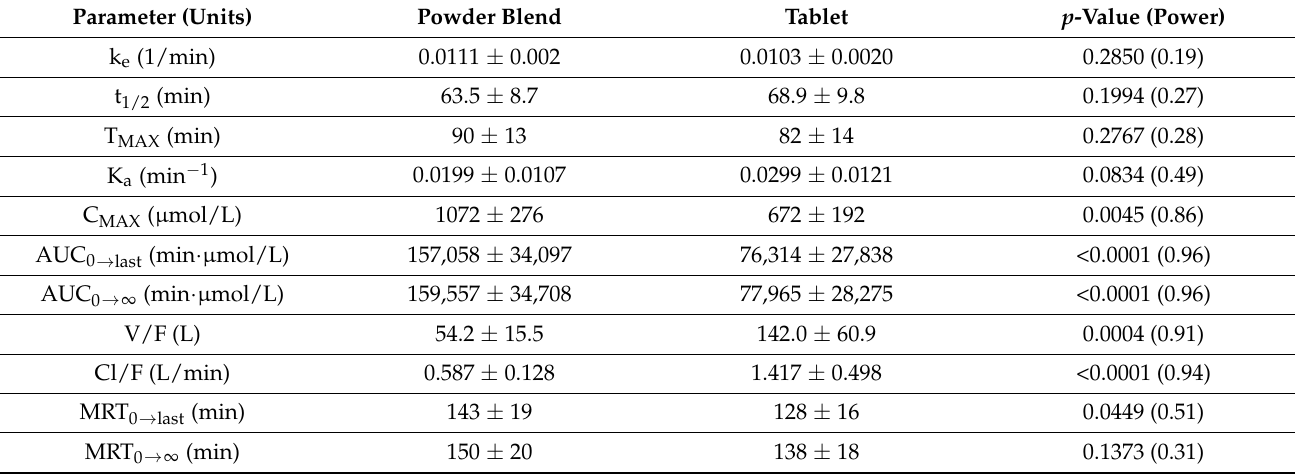
Table 1. Non-compartmental pharmacokinetic parameters of the test and reference formulations.